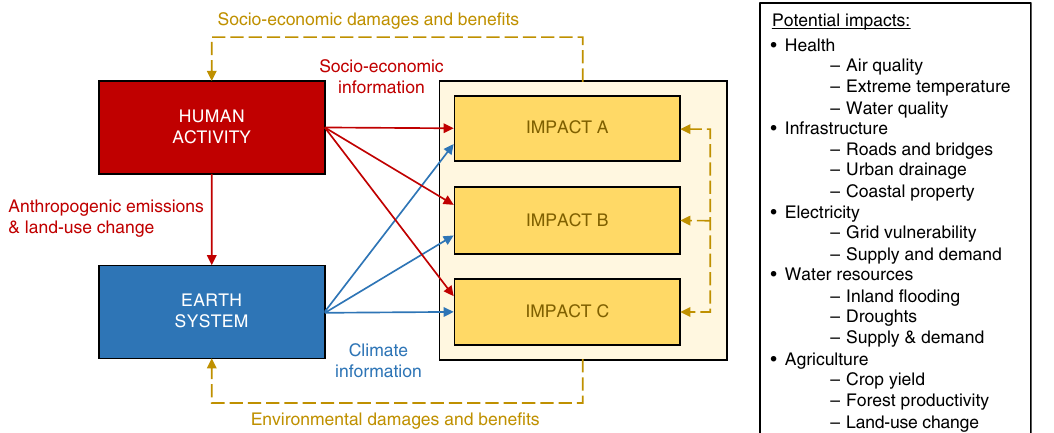
Fig. 1 Conceptual representation of a coupled human-Earth system model with improved integration of physical impact models. Different coupling strategies between the various components of the modeling framework are represented by the different arrows. Potential impacts are listed in the